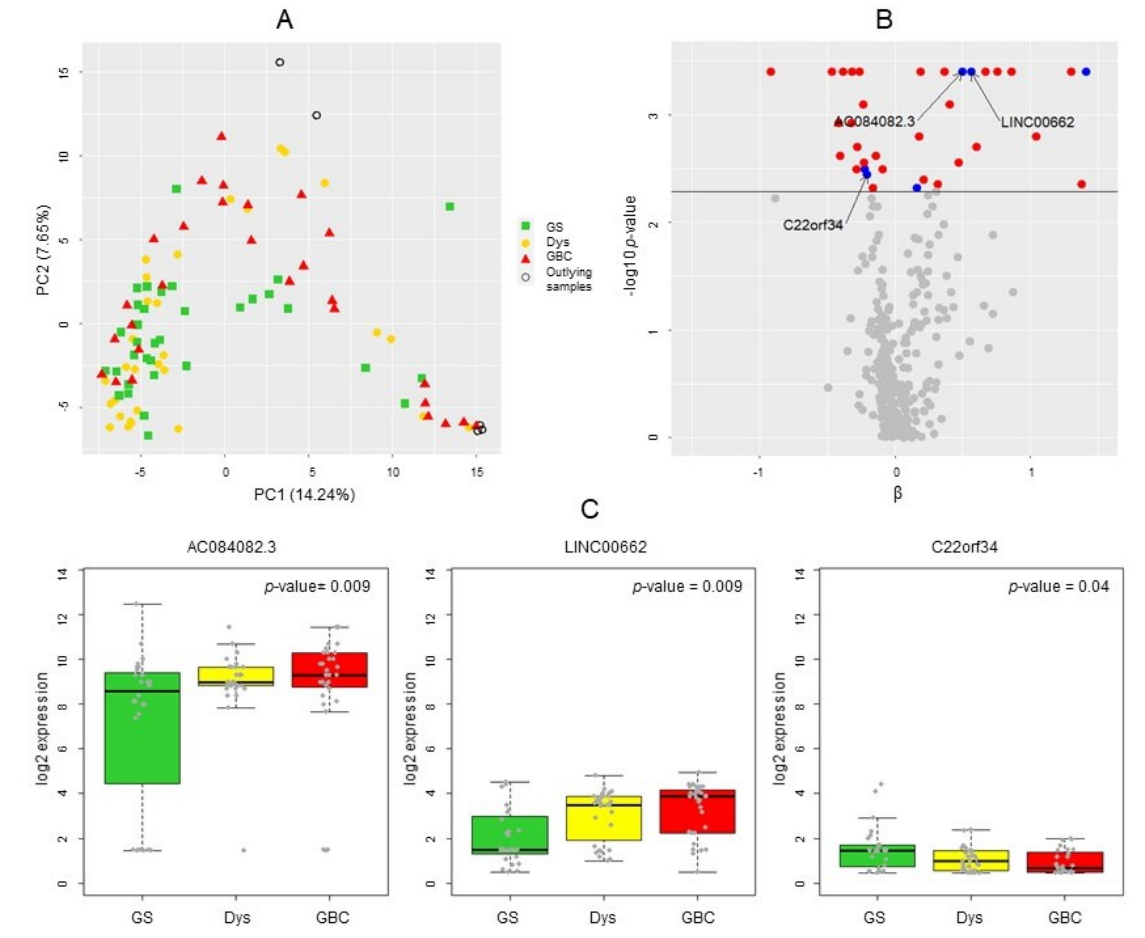
Figure 2. LncRNA preselection. ( A ) PCA based on normalized log2 expression counts for lncRNAs with a nonzero MAD expression in the preselection dataset. ( B ) Volcano plot for the lncRNAs with nonzero MAD expression investigated in the lncRNA preselection dataset. The y -axis shows − log10 p -values from J–T tests. The black line represents the applied threshold (FDR = 0.05). The red dots highlight lncRNAs preselected according to both J–T tests and ML, which showed low expression variability (MAD = 0) in serum samples. The blue dots show the six candidates that fulfilled both J–T and ML preselection criteria, with nonzero MAD expression in serum samples. ( C ) Dot-and-box plots of log2 expression in GS, Dys, and GBC tissue samples for the three preselected